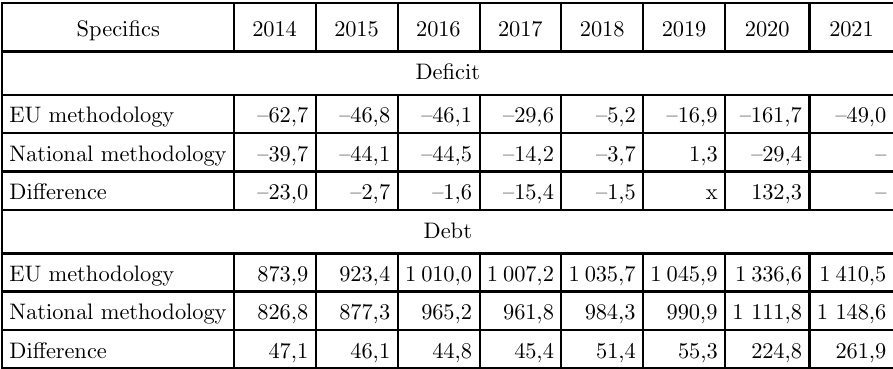
Public sector deficit and debt in Poland according to national and EU methodology